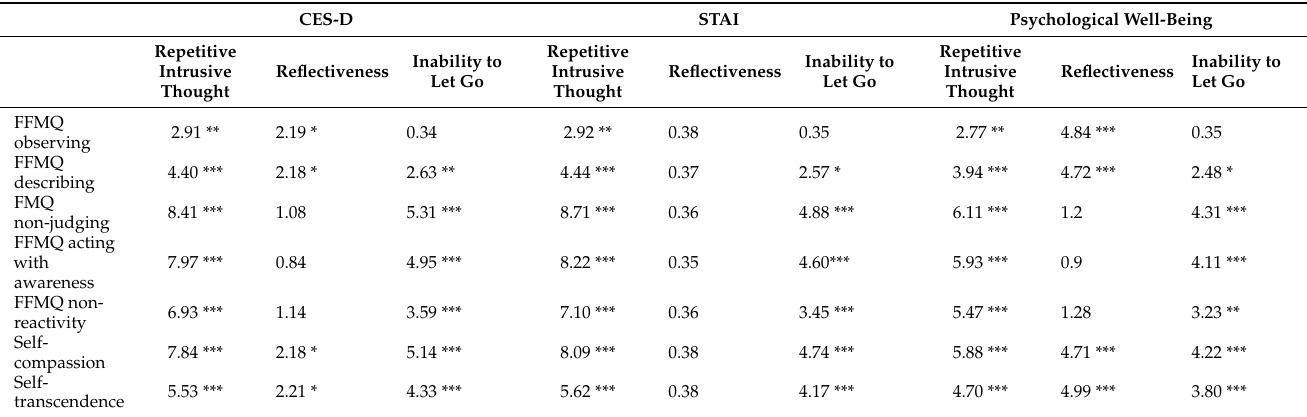
Table 5. Results from Sobel tests examining whether the inability to let go, repetitive intrusive thought, and reflectiveness significantly mediate between the seven mindfulness variables (FFMQ, self-compassion, and self-transcendence) and the three outcomes of dysphoria (CES-D), anxiety (STAI), and psychological well-being in Sample 2. All regression coefficients are beta coefficients (i.e., standardized coefficients).